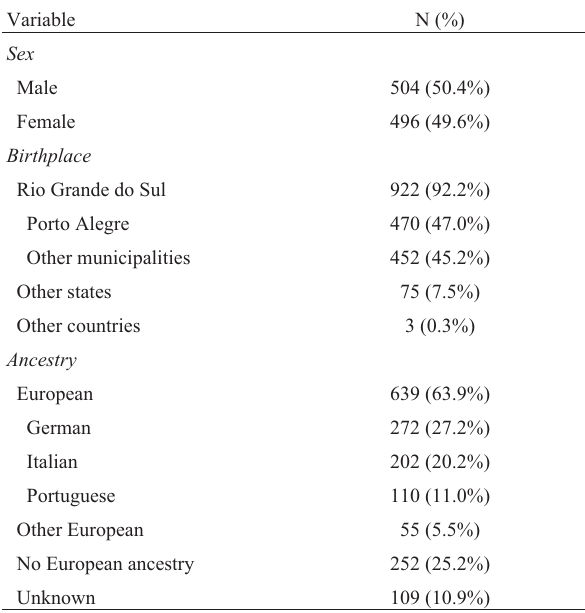
Table 1 - Characteristics of the study sample